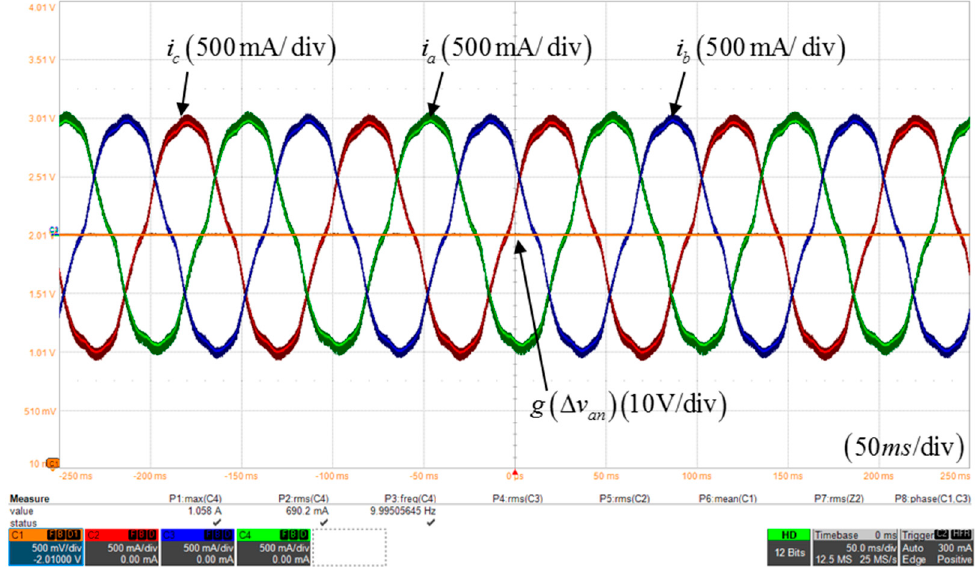
Figure 23. Three-phase currents waveforms and a-phase dead-time compensation pole voltage waveform without any DTCS.